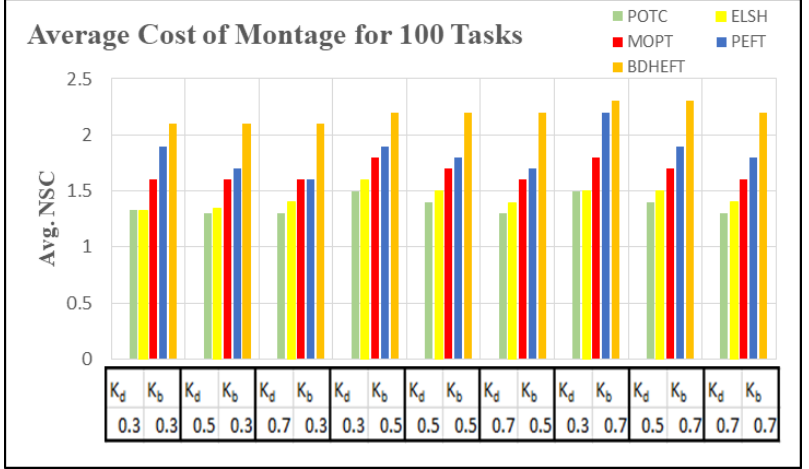
Figure 11. Average execution cost of the montage workflow for different deadline factors.